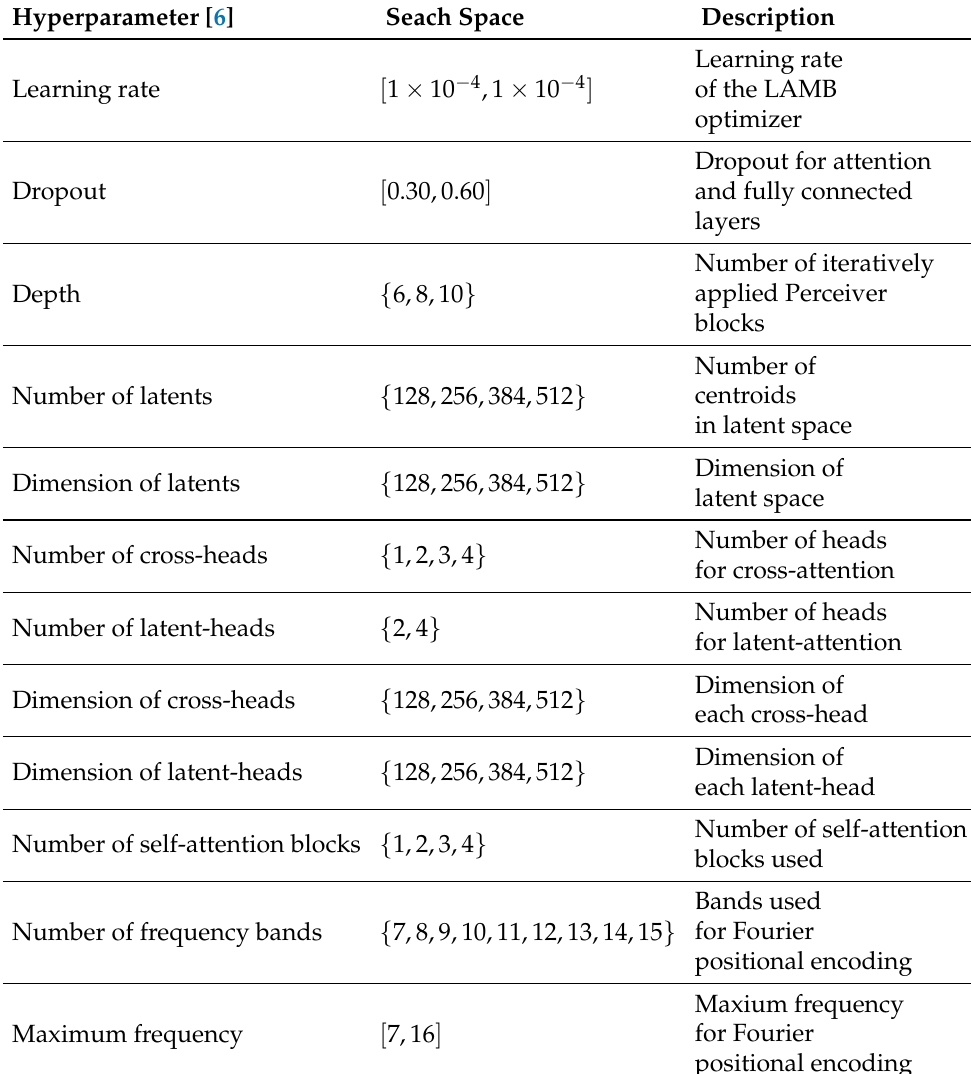
Table 2. Hyperparameter of the Perceiver networks and their search spaces. For all encodings, the same search spaces were used. Please note, continuous search spaces are denoted in square brackets, whereas (discrete) sets are denoted in curly